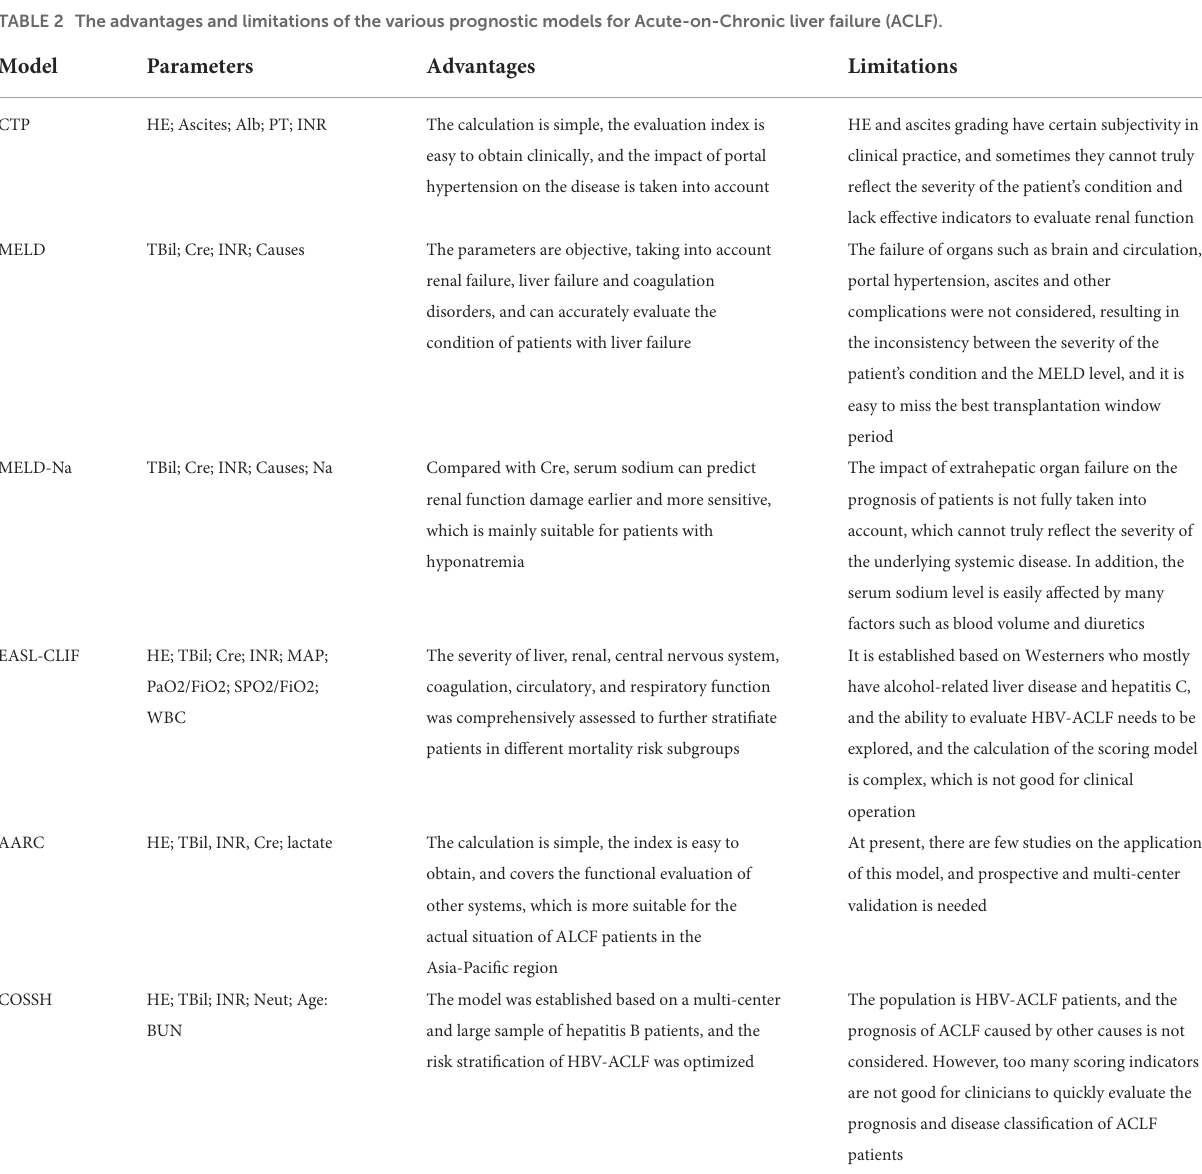
TABLE 2 The advantages and limitations of the various prognostic models for Acute-on-Chronic liver failure (ACLF).